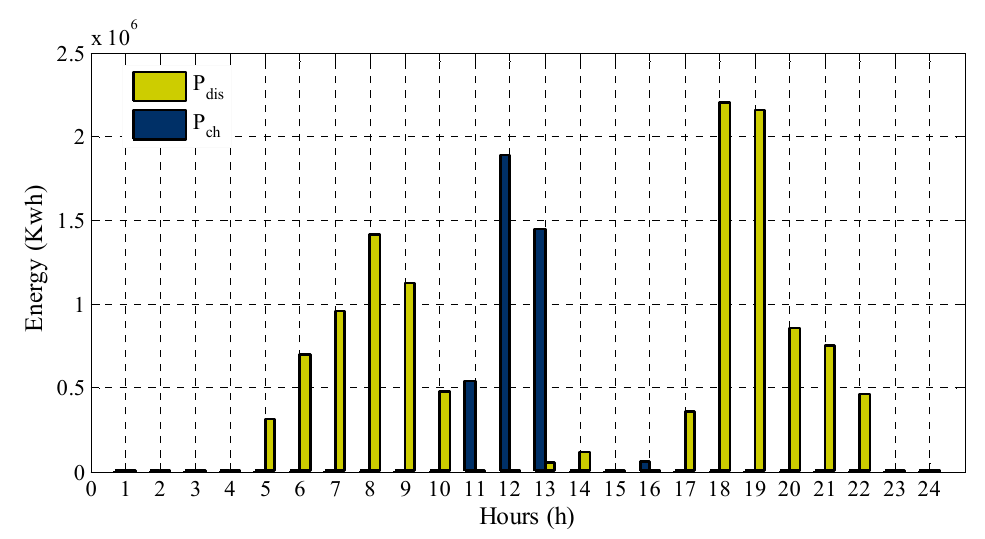
Figure 3. Expected charging and discharging powers of EVs.